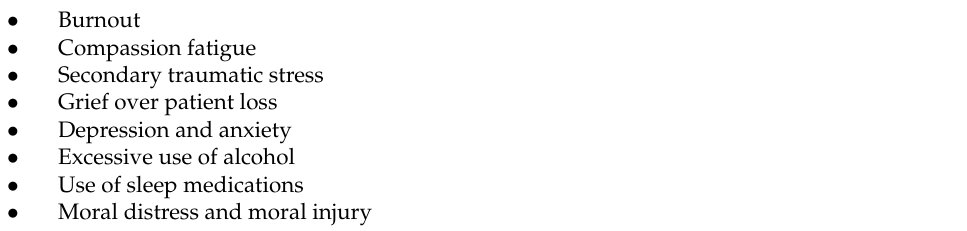
Table 1. Mental Health of Oncology HCPs Prior to the COVID-19